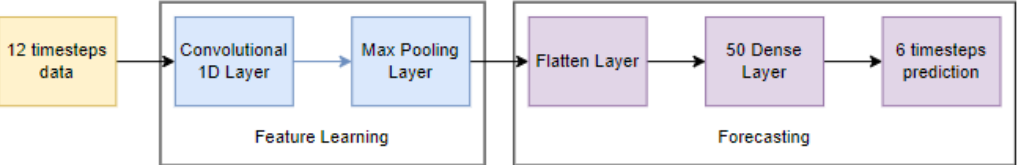
Figure 10. The 1D-CNN architecture used to predict blood glucose levels.